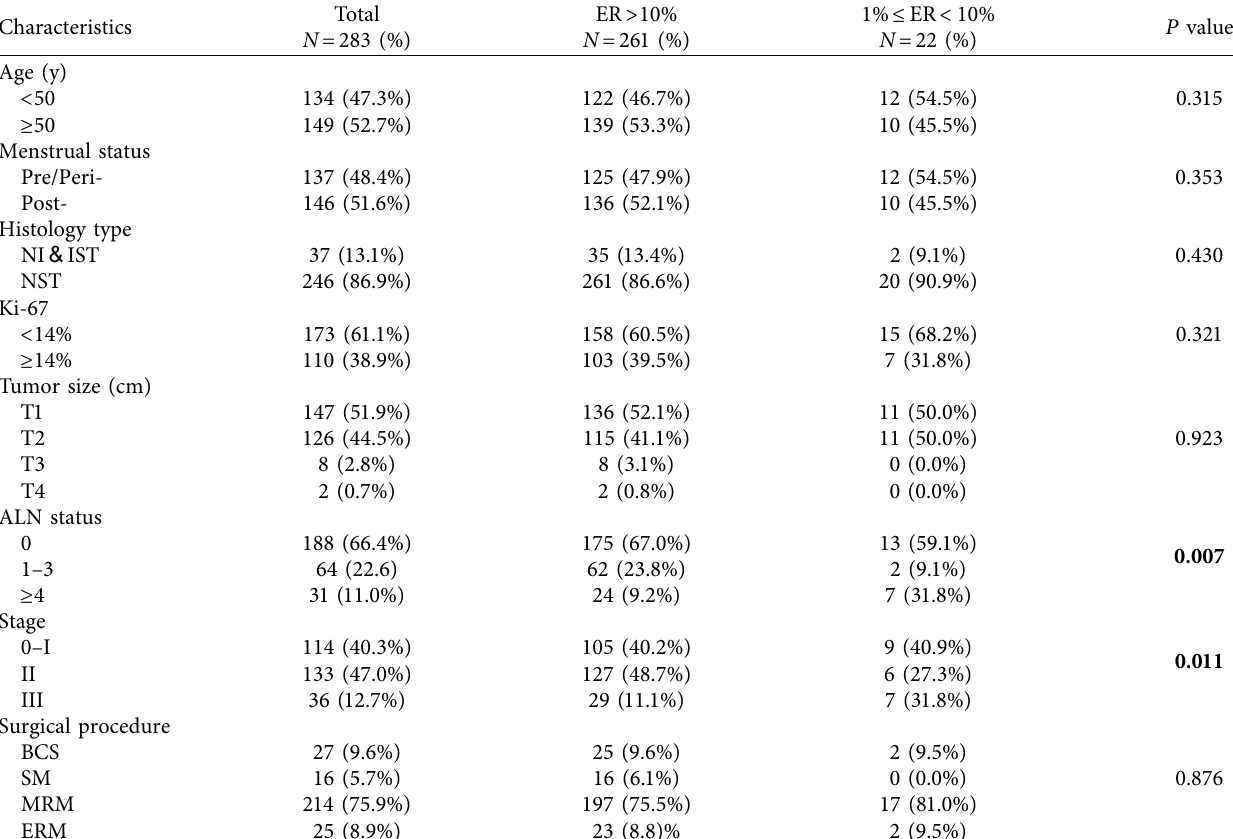
Table 1: Tumor and patient characteristics stratifed by the ER